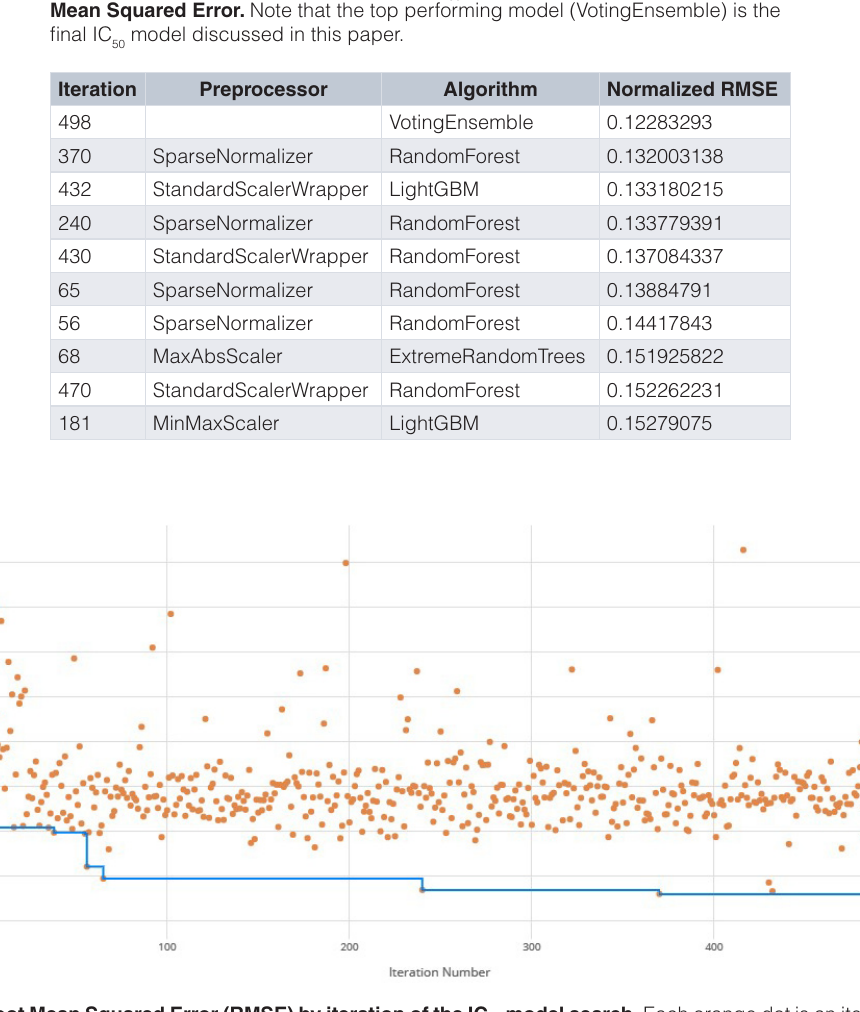
model search. Each orange dot is an iteration with 50